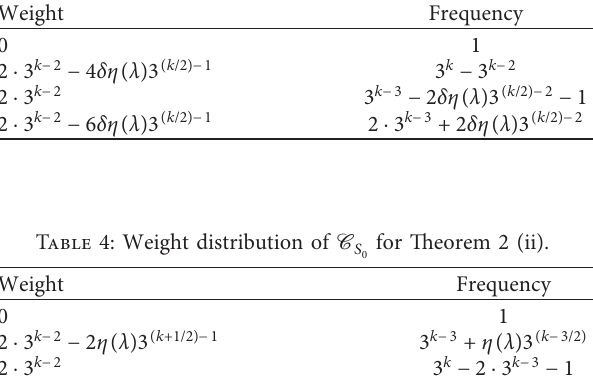
Table 1: Weight distribution of C